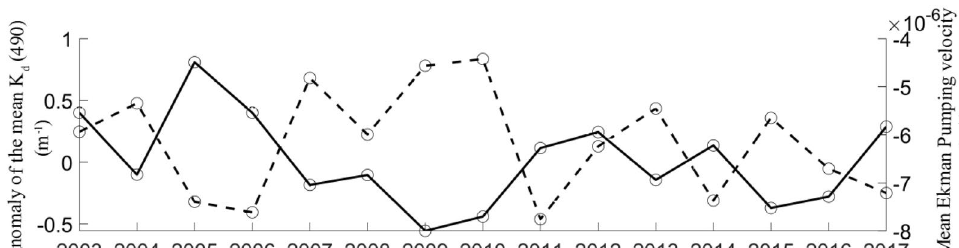
Figure 7. The time series of the mean K d (490) anomalies and the mean Ekman pumping velocities in coastal waters less than 25 m deep between November and December from 2003 to 2017. The solid line represents the mean K d (490) anomalies in coastal waters less than 25 m deep between November and December from 2003 to 2017. The dashed line represents the mean Ekman pumping velocities in coastal waters less than 25 m deep between November and December from 2003 to 2017. The program R (version 3.6.3, available at https:// www.r- proje ct. org) was applied for the